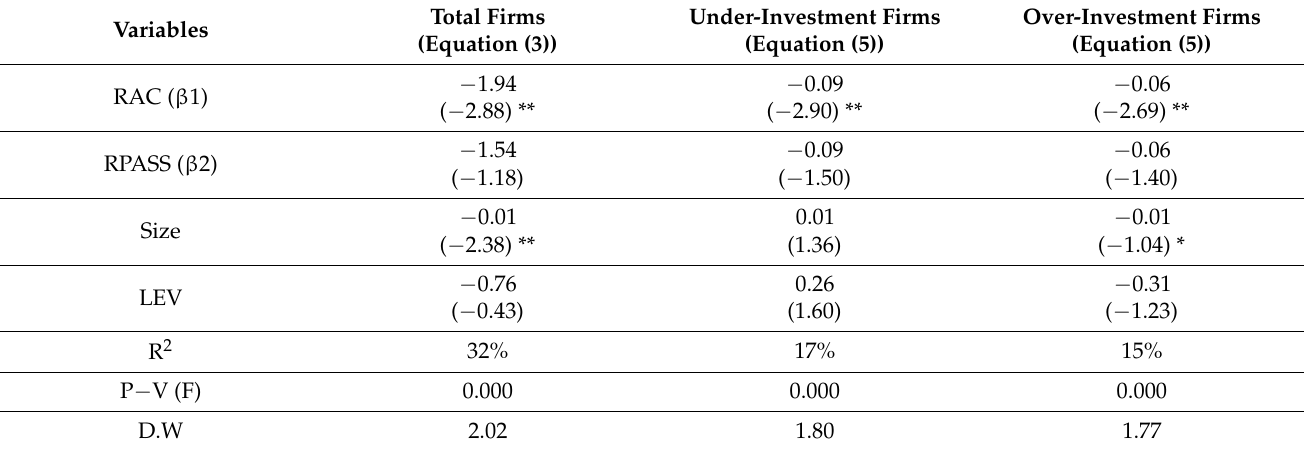
Table 6. Investment efficiency and institutional ownership